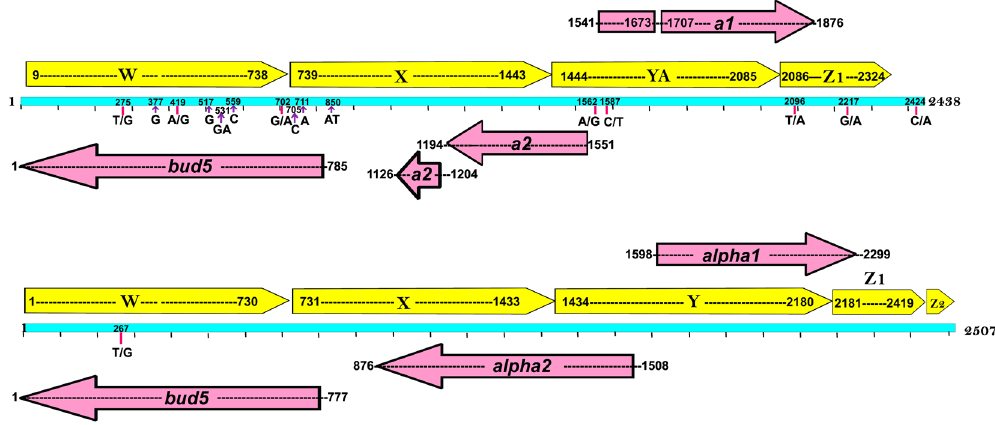
Figure 2. MAT Locus of Sb biocodex depicting the annotated regions. ( A ) MATa locus with yellow arrows depicting the MAT region divided in W, X, Y A and Z1 regions with coded MATa1 and MATa2 regulatory proteins. ( B ) MAT α locus with yellow arrows depicting the MAT region divided in W, X, Y, Z1 and Z2 regions with coded MAT α 1 and MAT α 2 regulatory